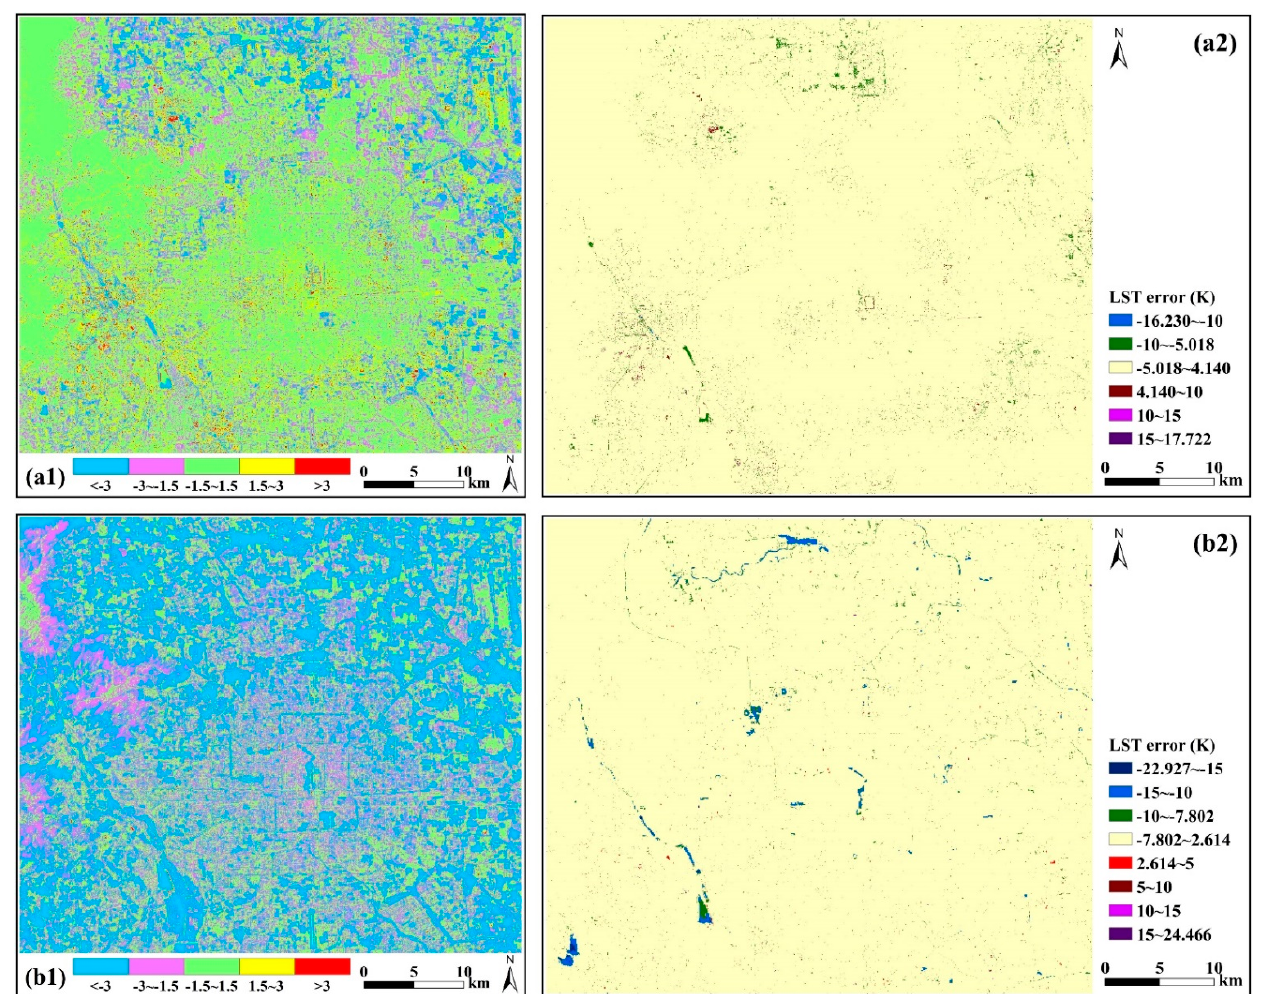
Figure 15. Spatial distribution of LST errors (K) in the MFGWML and HUTS models for Scheme 1. Plots ( a1 , b1 ) represent the spatial distribution of LST errors in the MFGWML and HUTS models, respectively. Plots ( a2 , b2 ) indicate LST error outliers for MFGWML and HUTS, respectively. In the plots ( a2 , b2 ), different colors, except for the light yellow color, indicate outliers with different ranges of LST errors. Table 12. Proportional values of LST errors in MFGWML and HUTS for the six downscaling schemes performed around the central urban area.